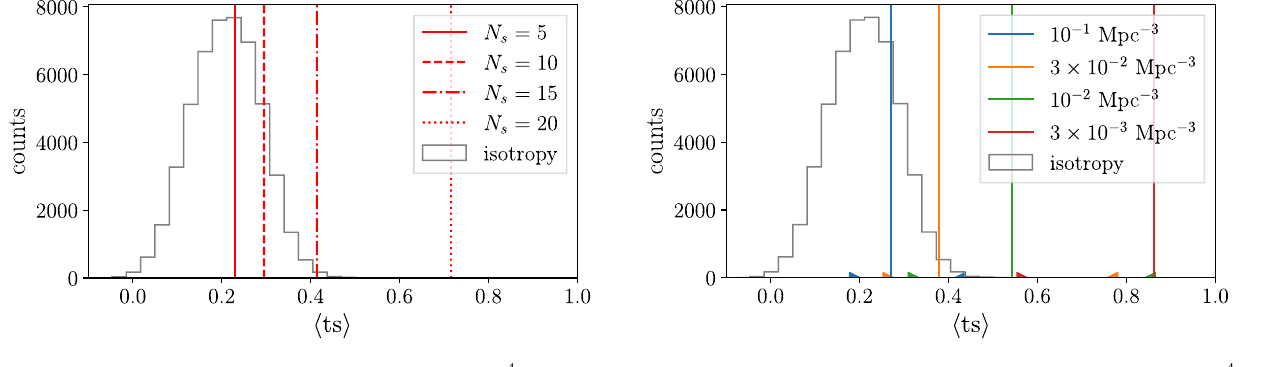
+ 0 . 16 , 0 . 38 + 0 . 39 , 0 . 54 + 0 . 31 , 0 . 86 + 1 . 92 − 0 . 08 − 0 . 11 − 0 . 22 − 0 . 30